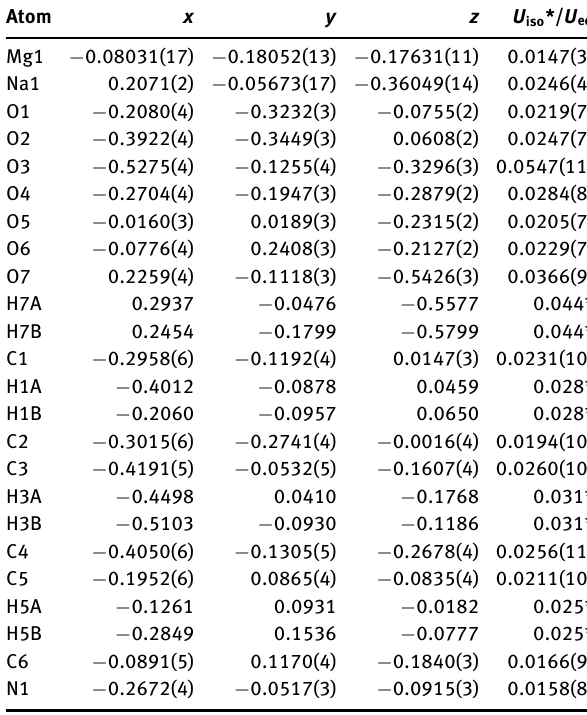
Table 2: Fractional atomic coordinates and isotropic or equivalent isotropic displacement parameters (Å 2